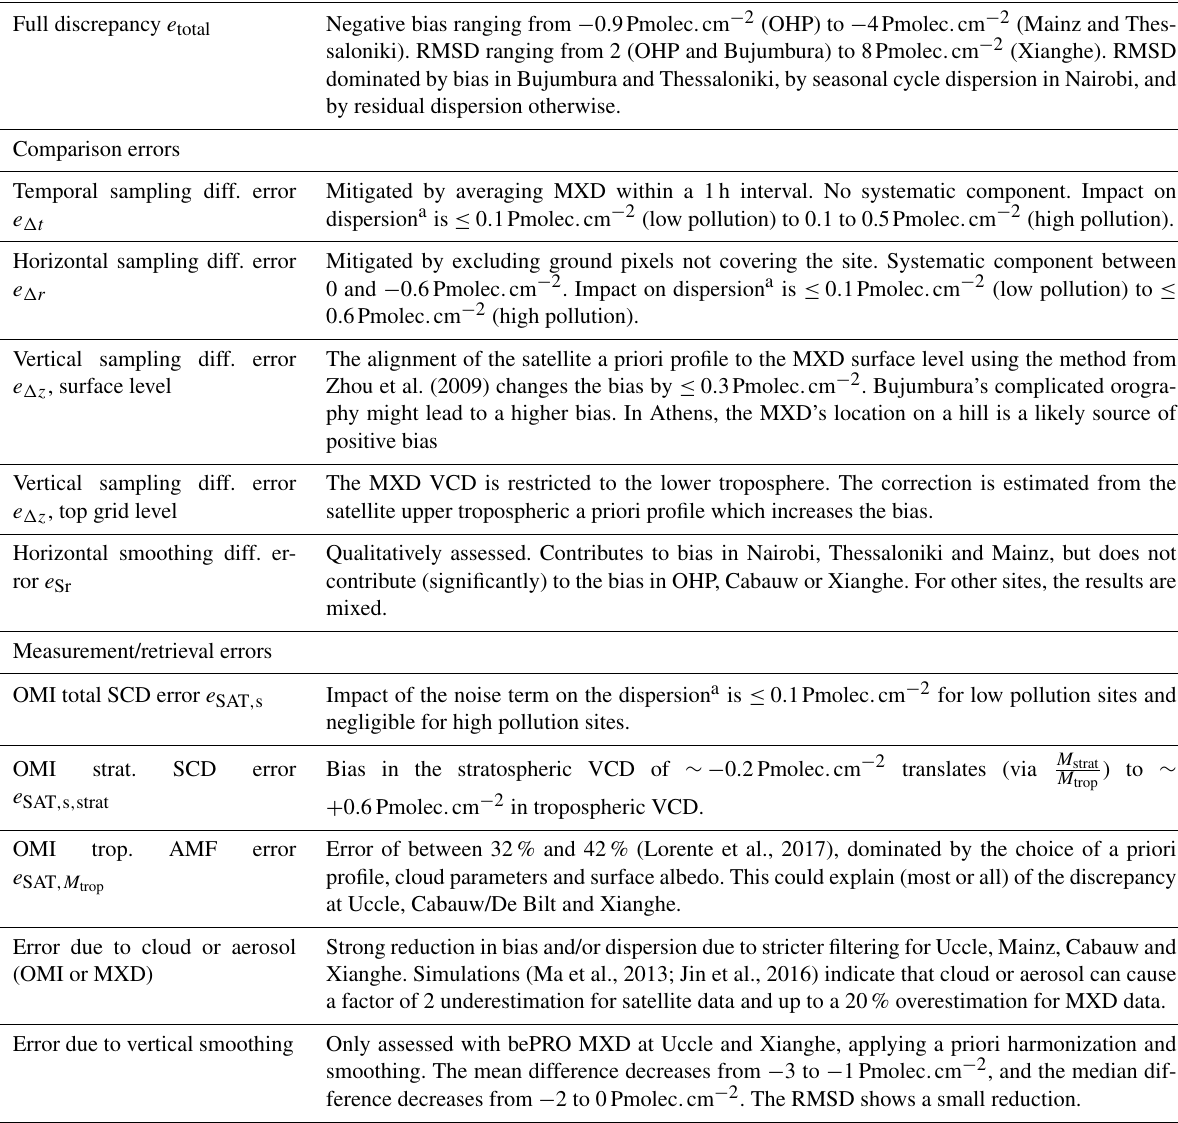
Table 3. Overview of discrepancies and error sources studied in this work. (MXD refers to MAX-DOAS.) Contribution